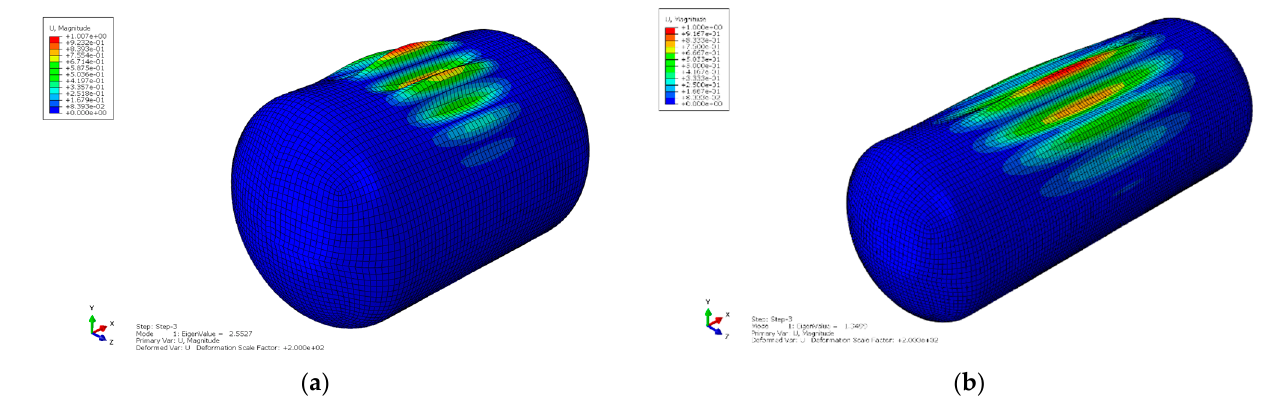
Figure 13. Visualisation of buckling analysis results for test cases #1 ( a ) and #2 ( b ) under ultimate downward inertial loads ( 𝑛 (cid:3045) = 4.5 ).